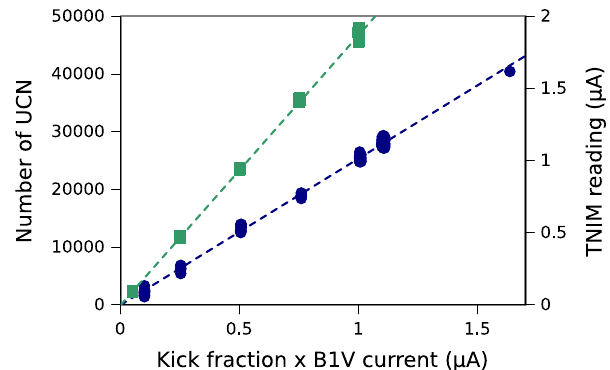
FIG. 21. The current measured by the TNIM (circles) and the number of UCN extracted from the UCN source (boxes) increase linearly with the beam current calculated from the kicker parameters and the current in beamline